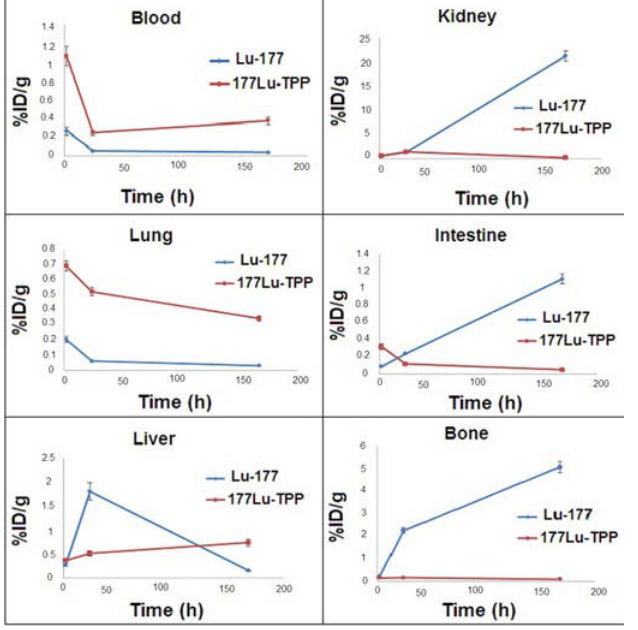
FIGURE 9 - Comparative organ uptake of 177 LuCl TPP in wild-type